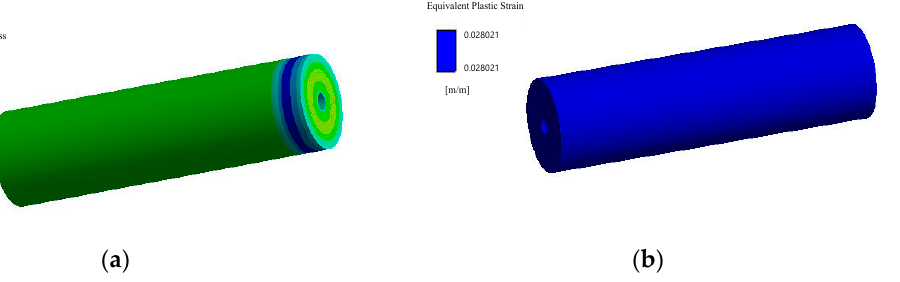
( b ) Figure 15. Equivalent stresses according to von Mises stress ( а ) and residual (plastic) relative linear strains ( b ) for composite with short cylindrical filler at the moment of full compression (second stage). 4.2. Verification of the Results of the Micromechanical Approach (First Stage) Mesh independence studies are performed to determine the results’ dependence on the mesh density of both stages. The average element size has varied over three iterations for each model. The percent relative errors for maximal equivalent Von-Mises stresses are less than 10% between the first and second size reductions and less than 1.5% between the second and third, which is satisfactory since a significant further increase in nodes obvi- ously does not lead to a significant increase in a stress state. In general, it turns out that simulation using the finite element method at the first stage predicts the strength of the considered materials well (Table 2). The strength limit is determined at the inflection point of the stress–total strain curves (Figures 12, 13a), where the loss of the load-bearing capacity of the volume of the cubic form made of composite materials of various fillers is postulated, with the subsequent dramatic development of the destruction processes. Considering the actual diagrams make it possible to signifi- cantly refine the prediction of strength limits and Poisson’s ratios and obtain calculated stress–total strain curves for the simulation of the mechanical processing of materials. Table 2. Characteristics of strength and elastic-plasticity for simulation models of composite mate- rials with a micromechanical approach (first stage). Composition ( Matrix/Filler )